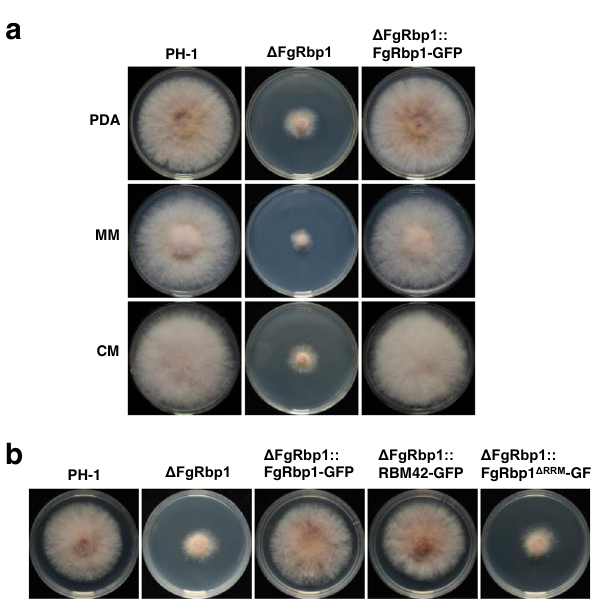
Fig. 1 Identi fi cation of the RRM-containing protein FgRbp1 in Fusarium graminearum . a Colony morphology of PH-1, the FgRbp1-deletion mutant ( Δ FgRbp1), and the complemented strain ( Δ FgRbp1::FgRbp1-GFP) on potato dextrose agar (PDA), complete medium (CM), and minimal medium (MM) at 25 °C for 3 d. b Heterologous complementation with human protein RBM42 and functional analysis of the RRM domain in FgRbp1. The construct expressing human RBM42 and FgRbp1 Δ RRM were independently transformed into Δ FgRbp1. The resulting strains Δ FgRbp1::RBM42-GFP and Δ FgRbp1::FgRbp1 Δ RRM -GFP, along with the control strains Δ FgRbp1:: FgRbp1-GFP, Δ FgRbp1 and PH-1 were cultured on PDA at 25 °C for 2